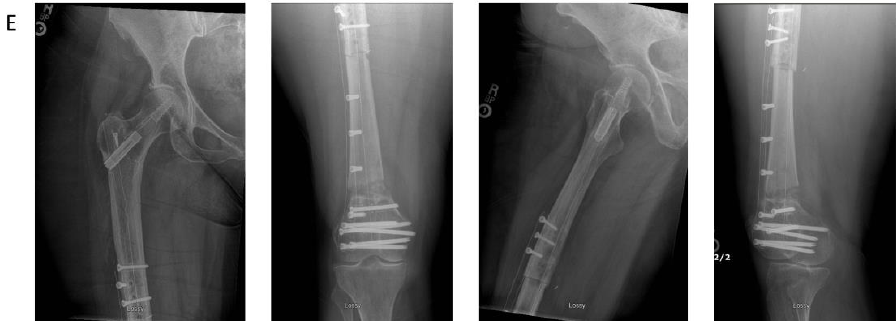
Figure 4. ( A ) Pre-operative anteroposterior (AP) and lateral radiographs of the right distal femur, demonstrating a lesion in the distal metadiaphysis. ( B ) Pre-operative post-contrast, T1 fat-suppressed coronal, sagittal, and axial magnetic resonance (MR) images of the distal femur further characterizing the high-grade dedifferentiated chondrosarcoma. Note is made of the cortical breach and extramedullary soft-tissue component. ( C ) Immediate post-operative AP and lateral radiographs of the right femur, demstatus post intercalary resection with allograft reconstruction utilizing a carbon fiber cephalomedullary nail and carbon fiber plate. ( D ) 15-month post-operative AP and lateral radiographs of the right femur, demonstrating allograft non-union and hardware loosening. ( E ) The 6-week post-operative AP and lateral radiographs of the right femur status-post removal of the carbon fiber plate and non-union revision open reduction internal fixation with iliac crest bone graft with use of a carbon fiber plate. The carbon fiber hardware facilitated clearer visualization of the allograft–native bone interface to assess for subsequent bony